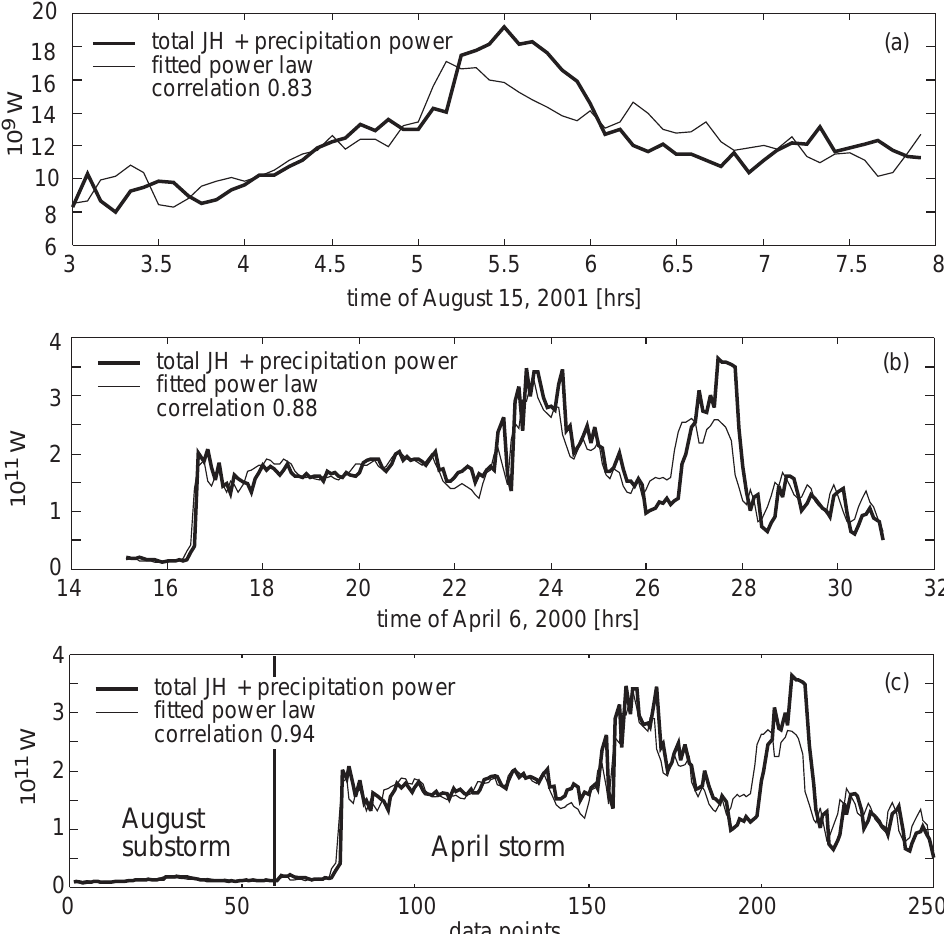
Fig. 13. Sum of Joule heating and precipitation powers (thick line) and fitted curve from Eq. (10) (thin line) for (a) 15 August 2001 substorm simulation, (b) 6 April 2000 storm simulation, and (c) both events merged to the same data vector. Note the different horizontal